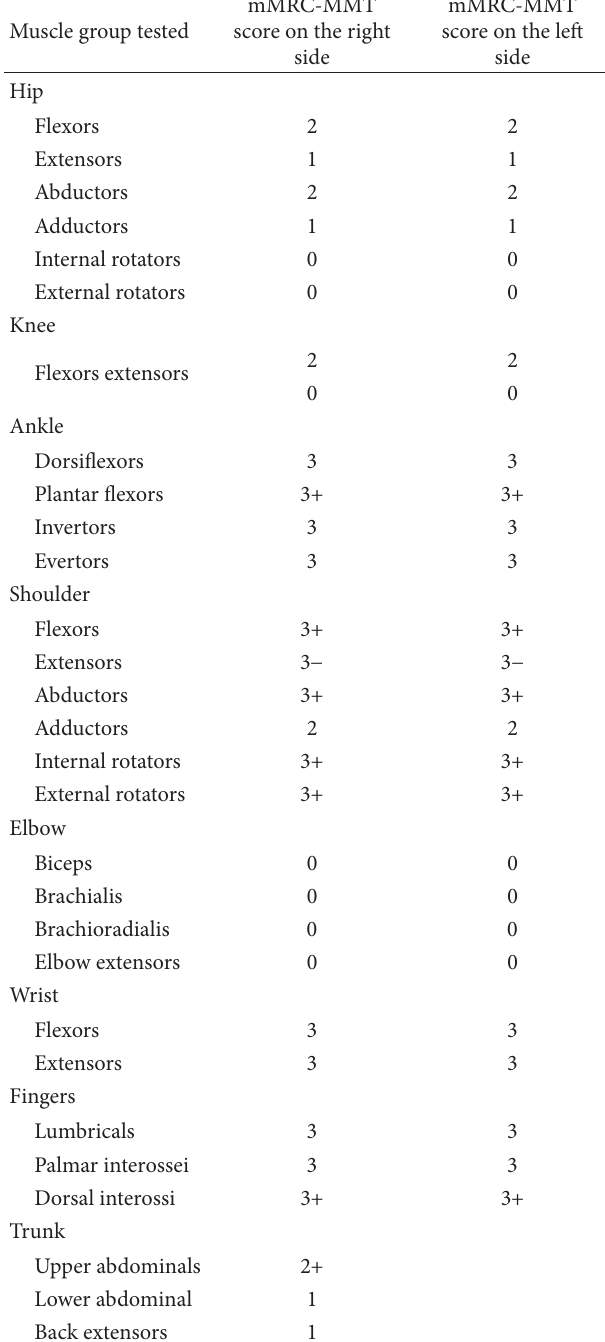
Table2:mMRC-MMTscalegradingforallthemusclesasexamined before stem cell